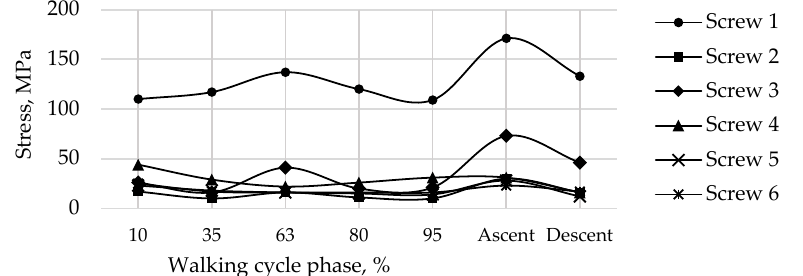
Figure 25. Maximum von Mises stress in each of the screws for pretension force of 50 N in different phases of the walking cycle.